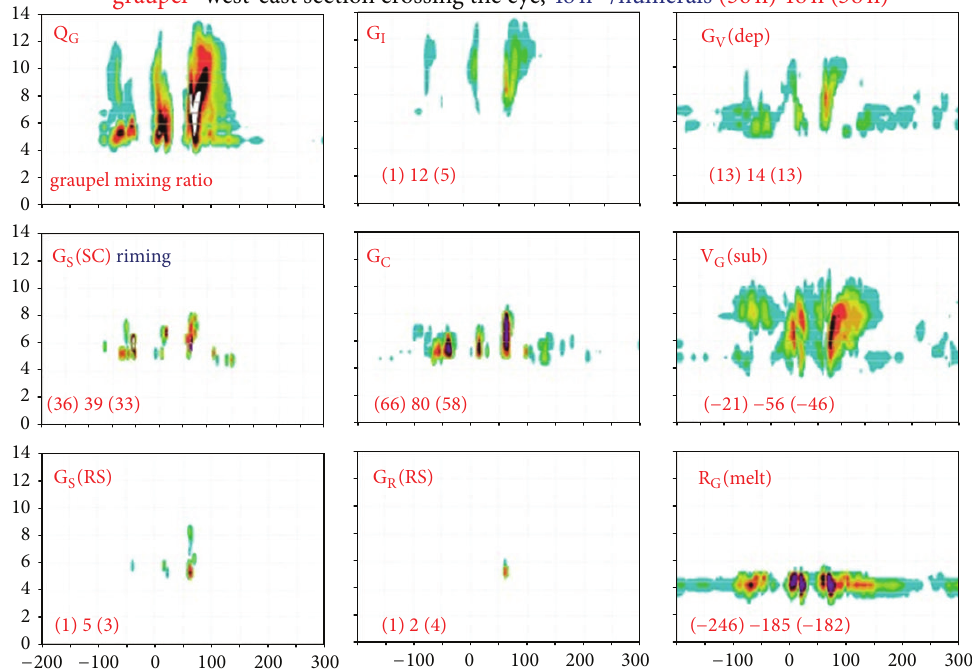
Figure 10: Same as Figure 9 but for graupel and cloud microphysics related to